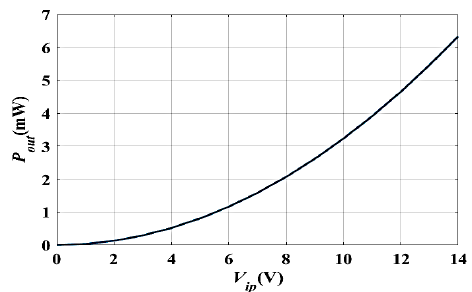
Figure 7. The simulation result of P out vs. V ip.